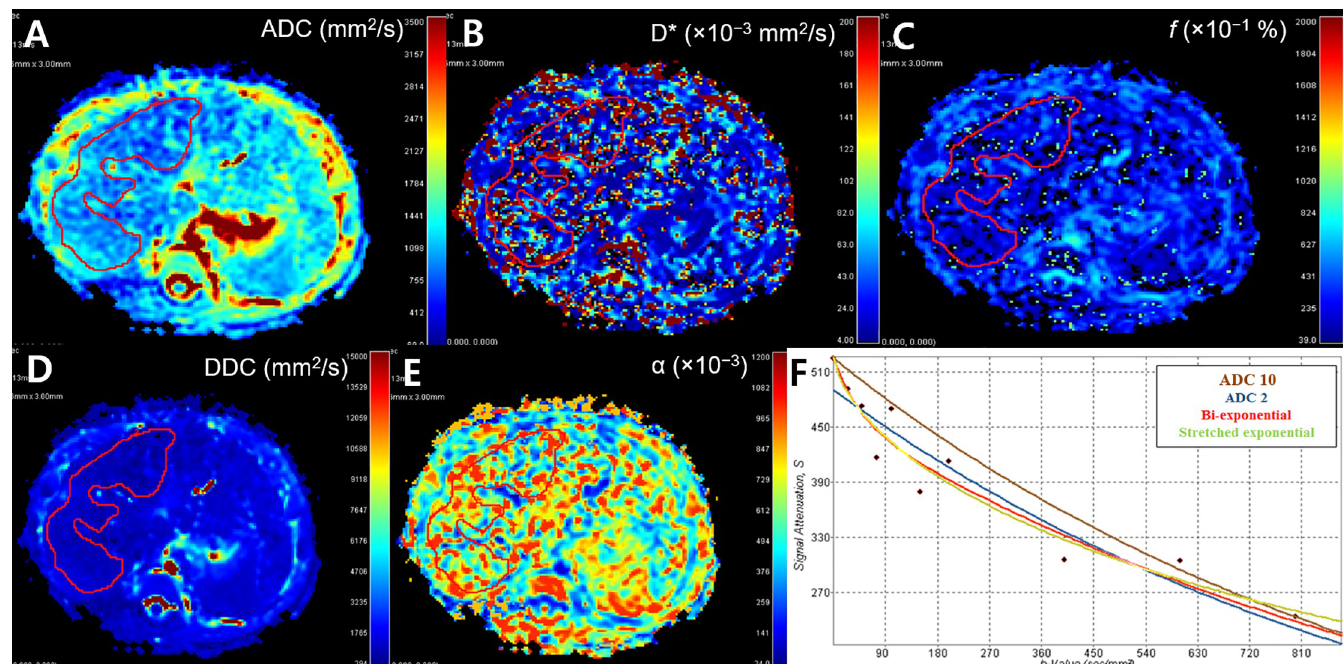
Fig 1. Liver diffusion MRI images of a 5-week-old girl in the BA group. Her initial total/direct bilirubin levels were 5.7/4.7 mg/dl, and her γ GT level was 403 IU/L. (A) The ADC with two b-values was 0.939 × 10 − 3 mm 2 /s. (B) The D � value was 22.6 × 10 − 3 mm 2 /s. (C) The f value was 8%. (D) The DDC value was 0.839 × 10 − 3 mm 2 /s. (E) The α value was 0.757. (F) Multi-parametric curves from the mono-, bi-, and stretched exponential models with the x-axis representing b-values and the y-axis representing diffusion-related signal attenuation.